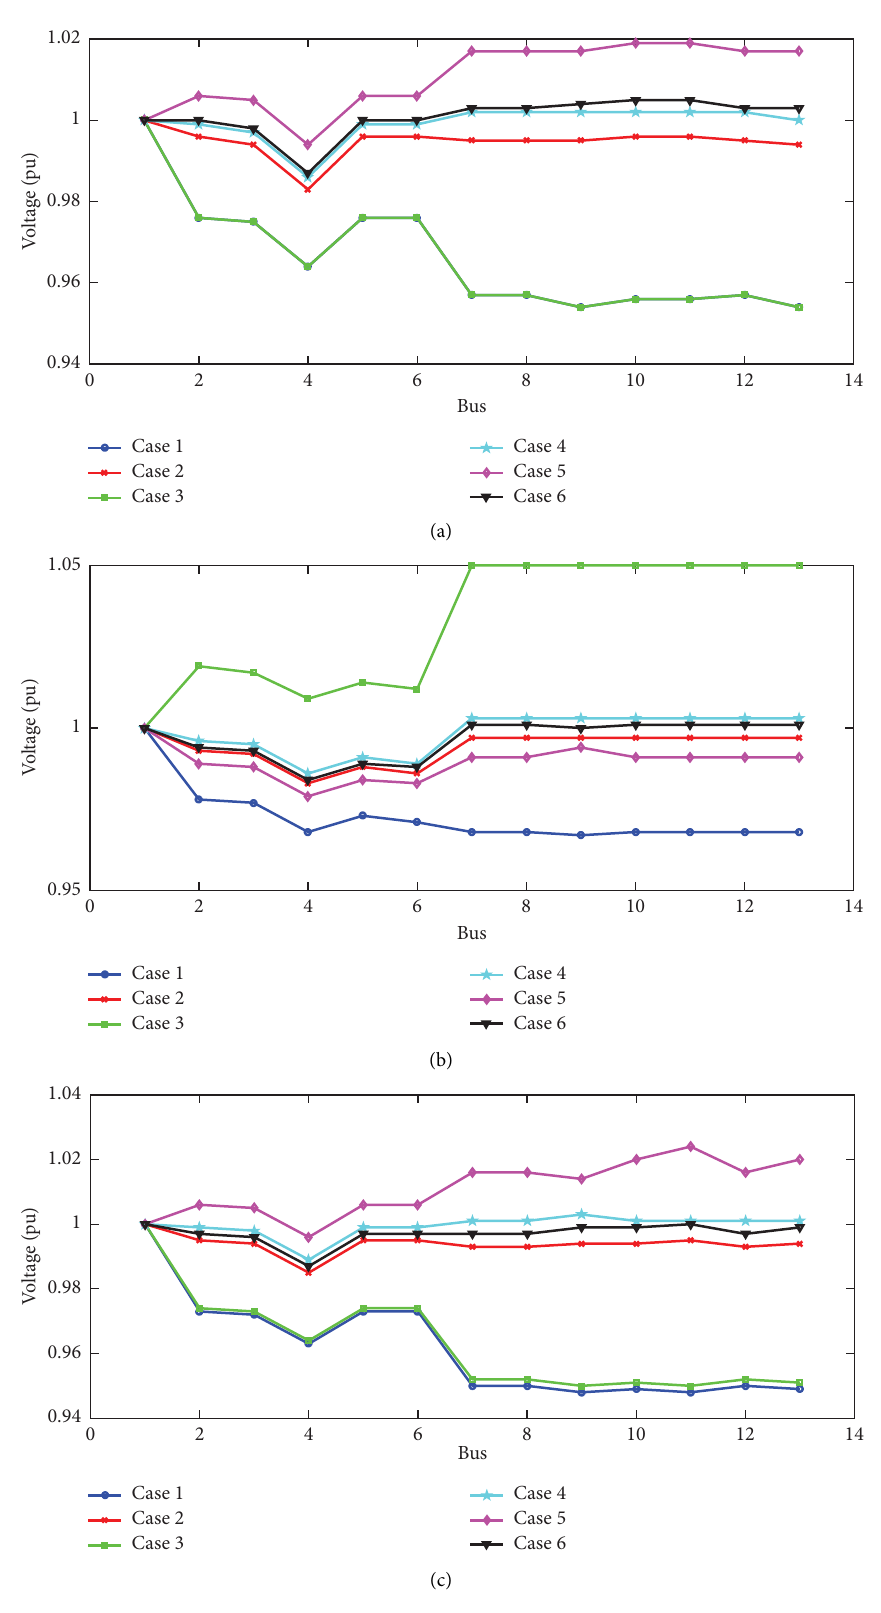
Figure 2: Voltage profle in diferent case studies: (a) the frst phase, (b) the second phase, and (c) the third